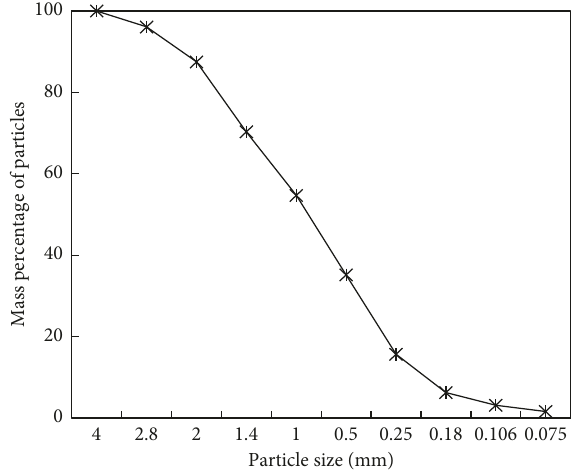
Figure 2: Curve of brick powder grading.